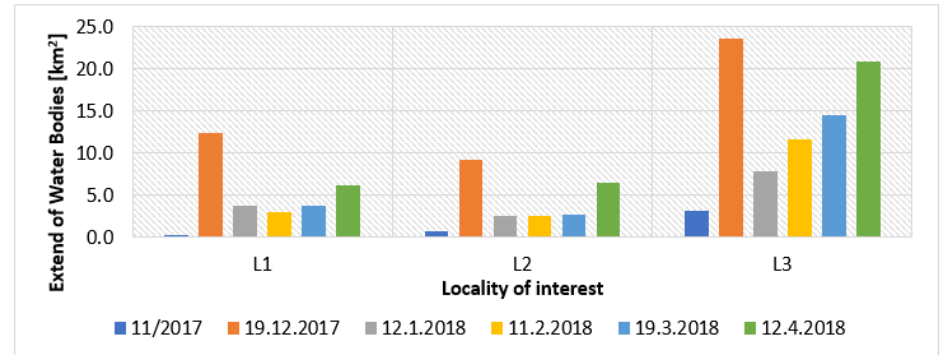
Figure 9. Interpretation of the results of the extent of water areas through a histogram based on Lee filtration with a window size of 3 × 3.